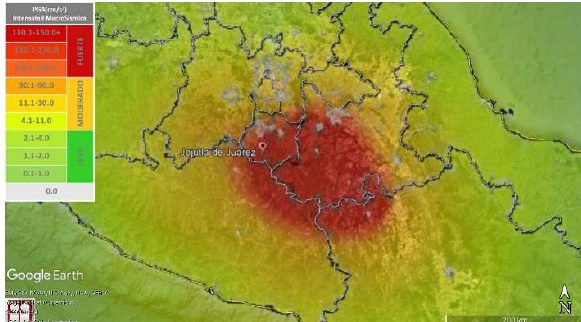
Figure 2. Seismic intensity of the 2017 Puebla Earthquake and location of Jojutla de Juárez. Source: Google Earth Pro / Servicio Sismológico Nacional.